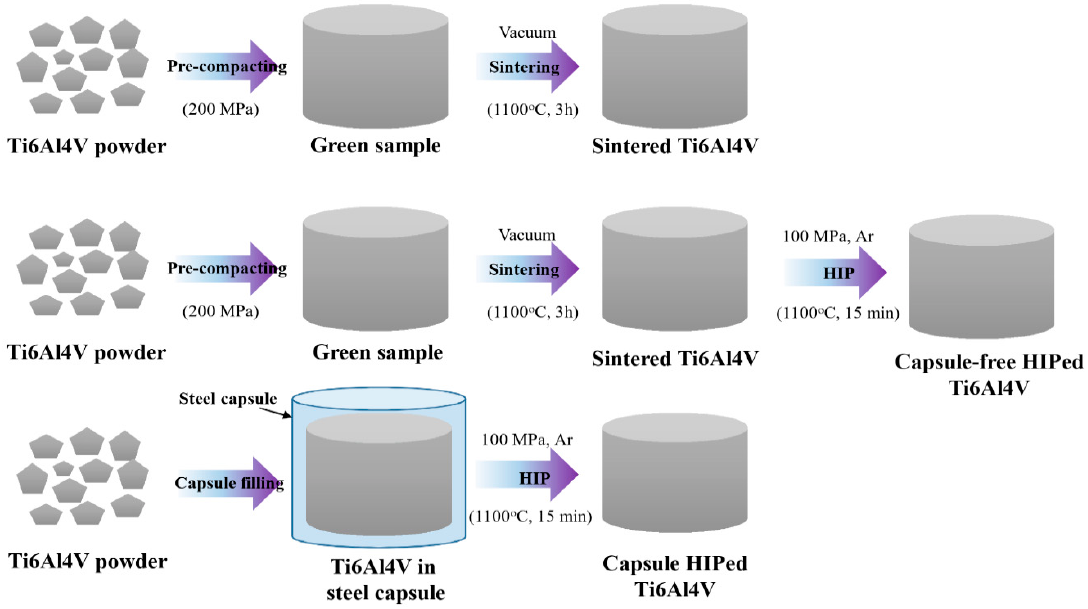
Figure 1. Fabrication process of Ti6Al4V alloys consolidated by different sintering techniques.